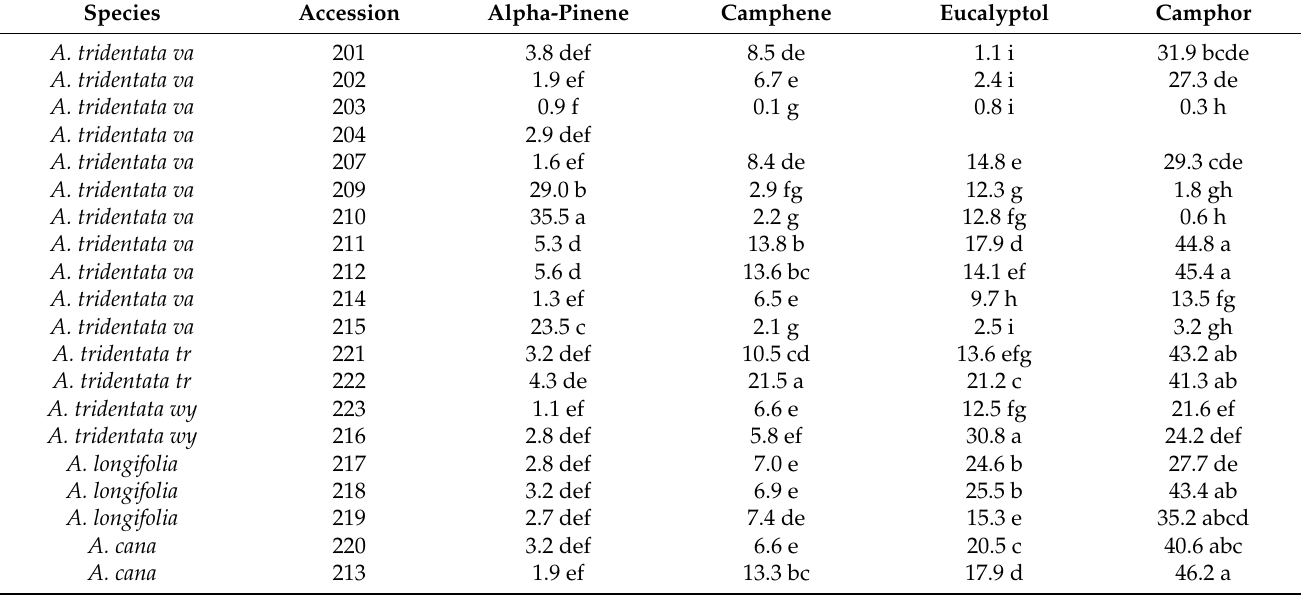
Table 2. Mean composition of alpha-pinene, camphene, eucalyptol and camphor (all in %) from six species and corresponding accessions. Blank cells indicate the constituents were not obtained from these accessions. A. tridentata va = A. tridentata Nutt. var. vaseyana ; A. tridentata tr = A. tridentata Nutt. var. tridentata ; A. tridentata wy = A. tridentata Nutt. var. wyomingensis